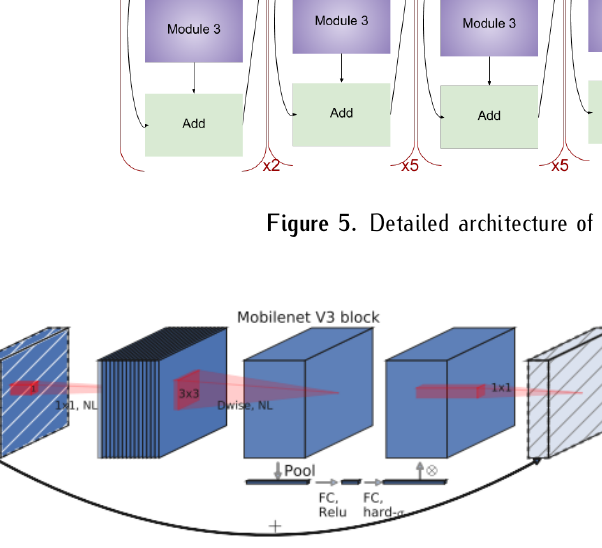
Figure 8. Detailed architecture of RegNet architecture neural network